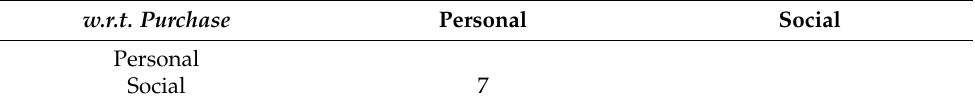
Table 10. Pairwise comparison matrix of sub-criteria of EMOTION with respect to PURCHASE